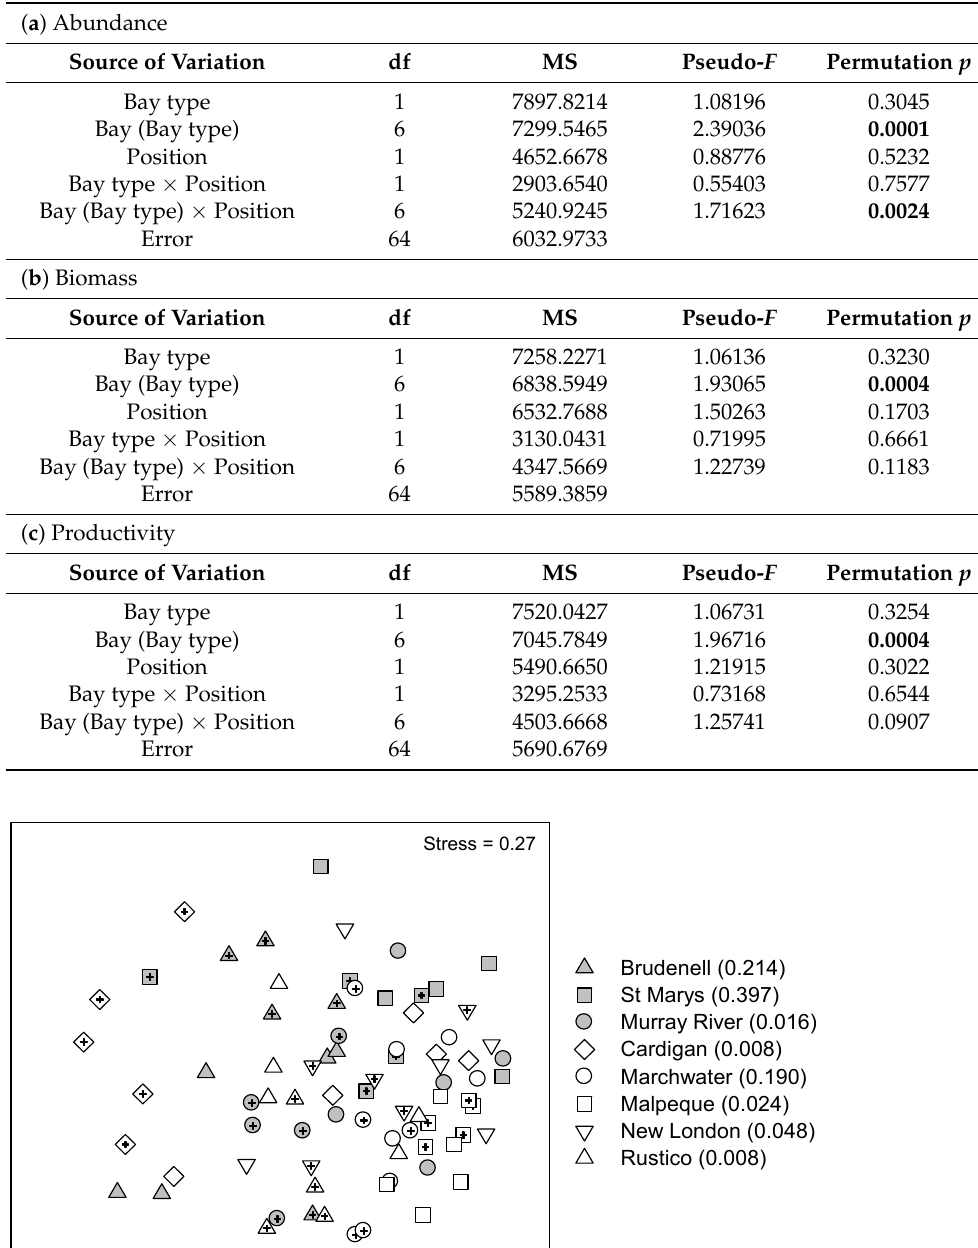
Table 4. DISTLM (Distance-based multivariate analysis) results testing fixed effects Bay type and Position on sediment macrobenthic assemblages using parameters ( a ) abundance, ( b ) biomass, and √ ( c ) productivity. Data for all 3 parameters were -transformed prior to analysis. Statistically signifi- cant effects are indicated in bold.